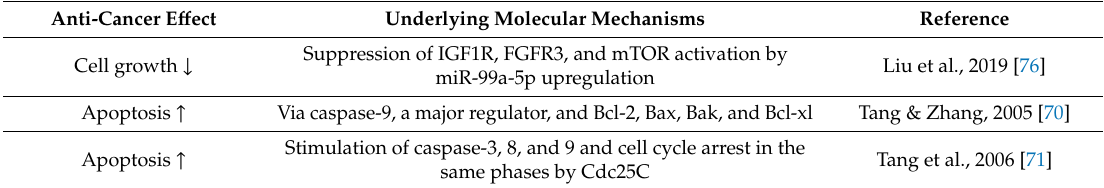
Table 2. In vitro molecular mechanisms of the anti-cancer e ff ects of benzyl